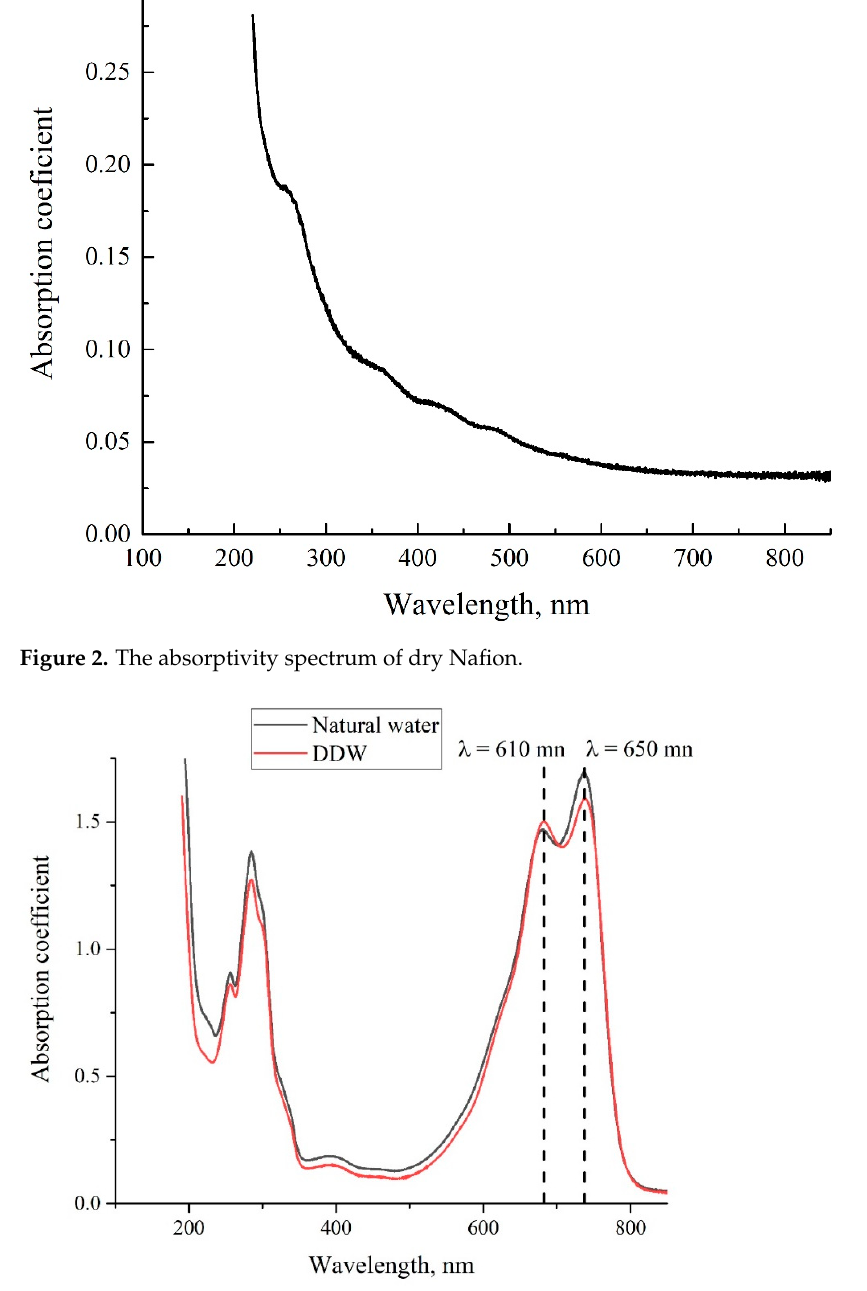
Figure 3. The absorptivity spectrum of the MB solution with concentration 0.015 mg/mL, based on natural water and DDW.